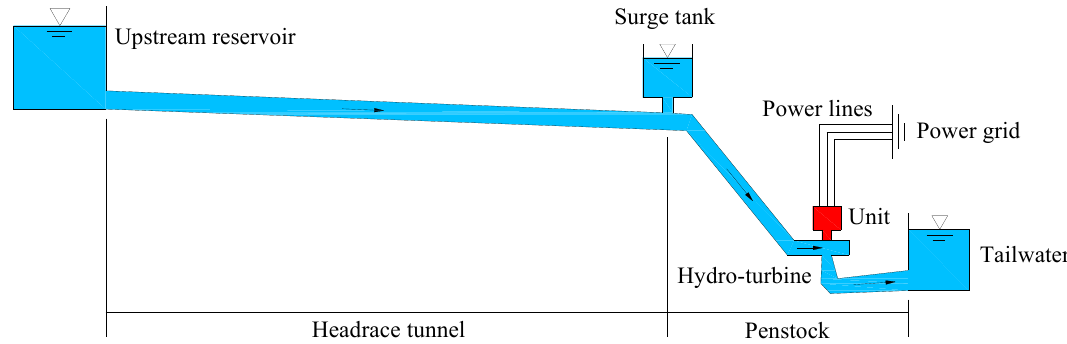
Figure 1. General structure of the pipeline and power generating system for a hydropower station with a surge tank.